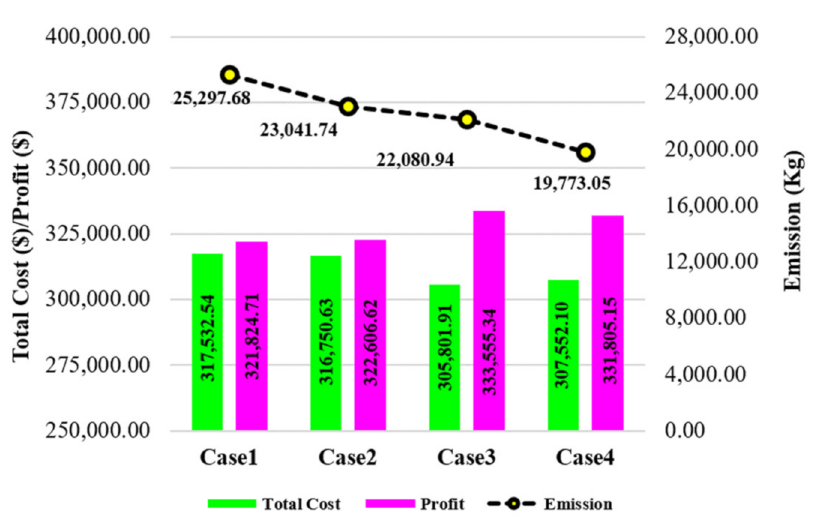
Figure 11. Comparison of cost, profit and emission under the scenario of emission minimization.